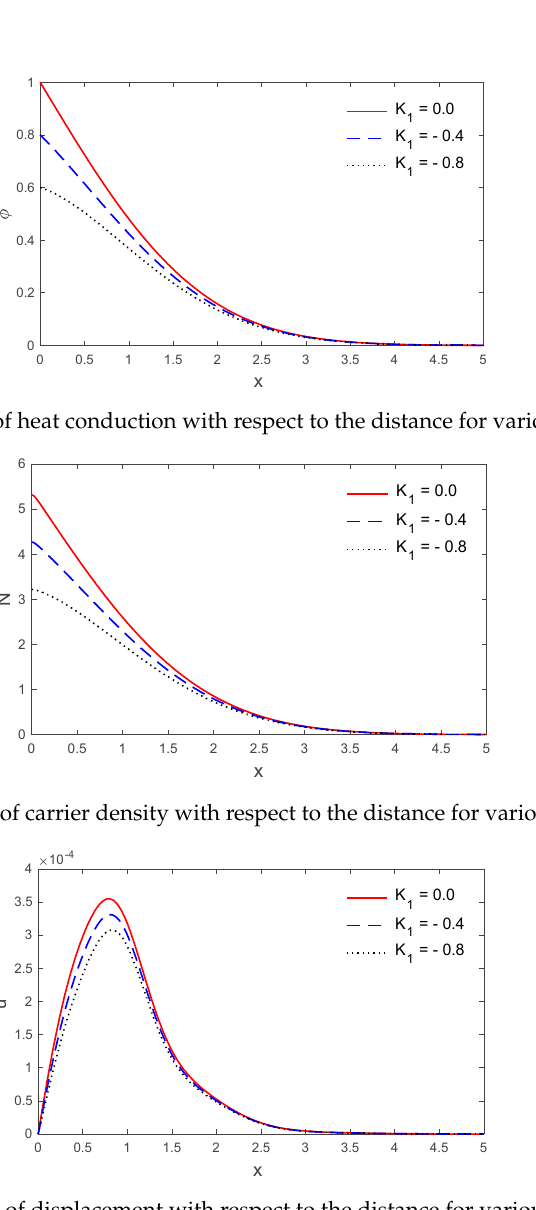
Figure 4. Variations of displacement with respect to the distance for various values of K 1 .